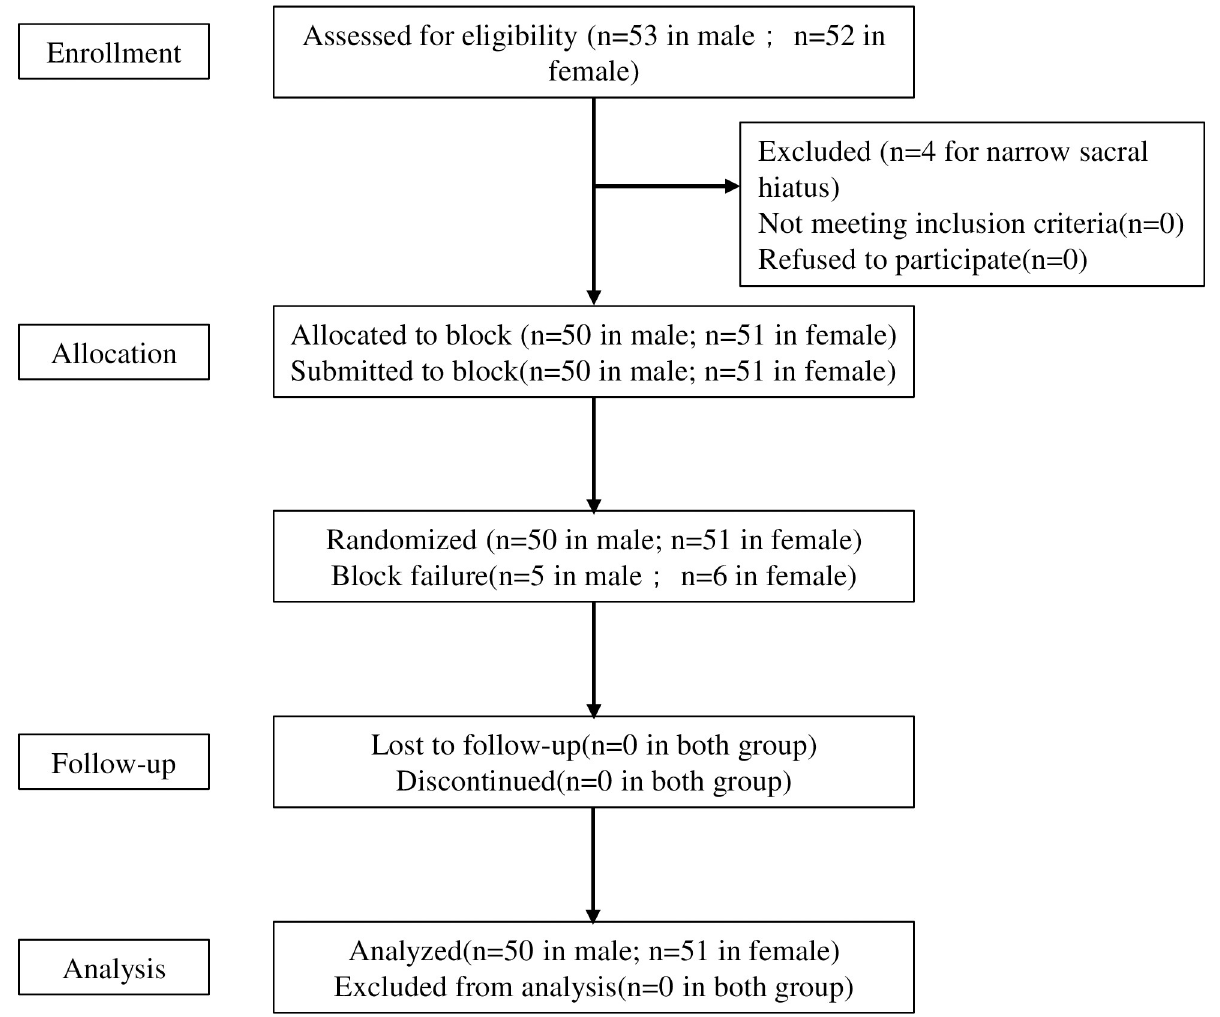
Fig 1. CONSORT flow